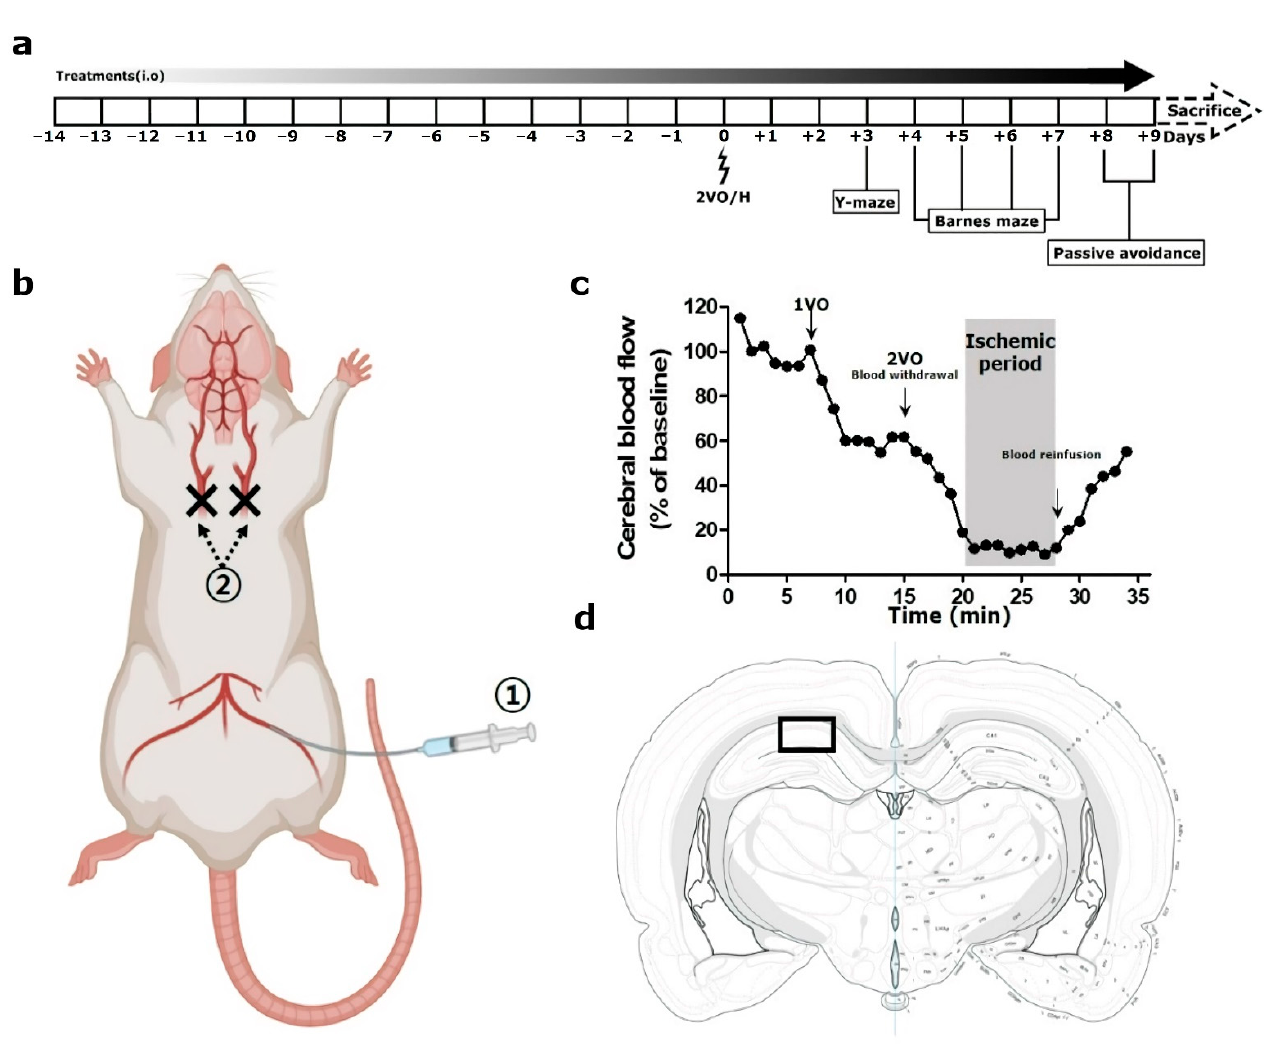
Figure 2. Graphical illustration of the in vivo experiment setup. ( a ) Schematic overview of the in vivo experiment, ( b ) surgical procedure, ( c ) a representative Doppler flowmetry traced for the entire operation time, and ( d ) the area of interest for histologic analyses in this study are presented. In ( b ), circled “1” and “2” represent the steps of femoral artery cathe- terization and ligatures of both common carotid arteries in the 2VO/H operation, respectively. In ( d ), a rectangular box indicates a 300 μ m-width area in hippocampal Cornu ammonis 1, which was used for histologic